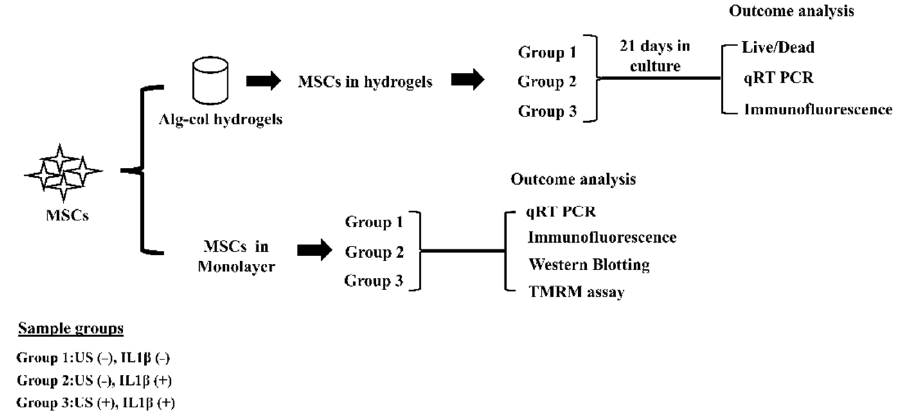
Figure 1. Experimental schematic. MSCs were seeded in alginate: collagen hydrogels or TCPs or coverslips, and divided into groups, as indicated. Group 1: cLIUS ( − ), IL1 β ( − ); Group 2: IL1 β (+), cLIUS ( − ); and Group 3: IL1 β (+) cLIUS (+). Appropriate sample groups were treated with cytokine at a concentration of 10 ng/mL. cLIUS stimulation was applied as follows:14 kPa (5.0 MHz, 2.5 Vpp), and 10 or 20 min/application. Non-cytokine treated and non-cLIUS-stimulated samples served as controls. Upon completion of the study, samples were retrieved and subjected to the indicated outcome analyses.